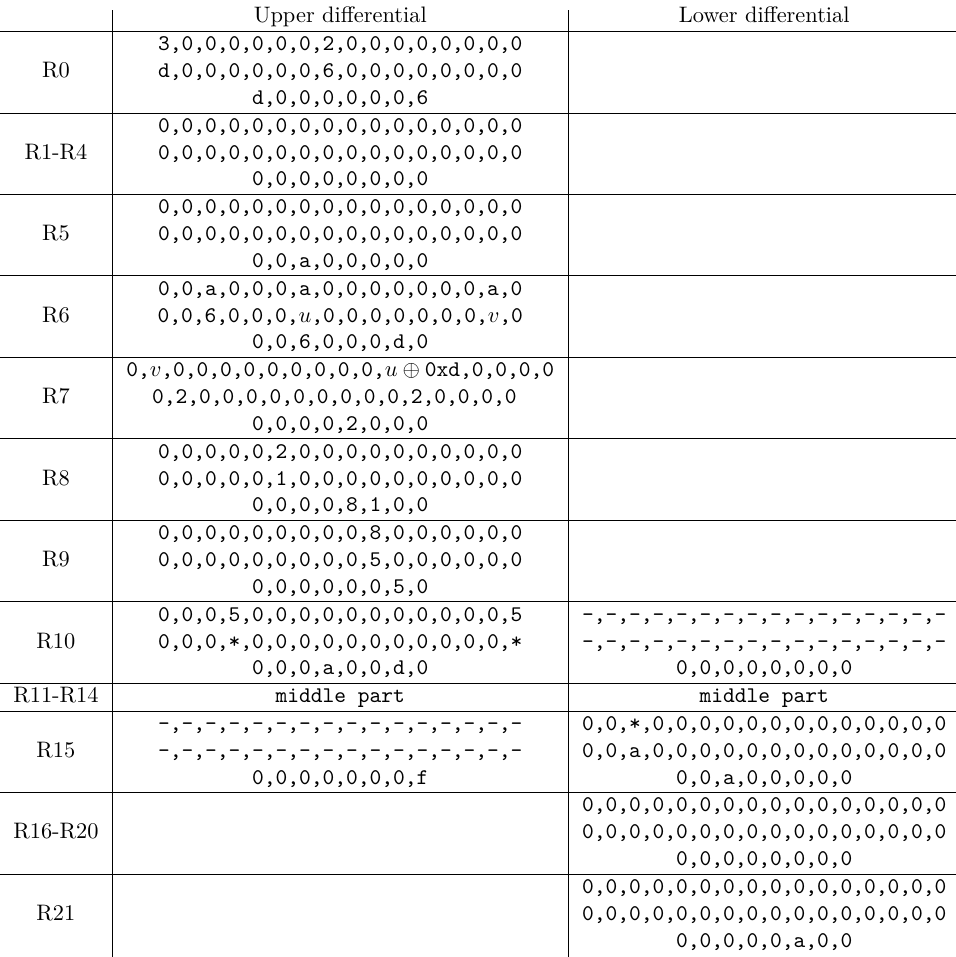
Table 17: The differentials of the 22-round distinguisher for SKINNY-64-192 , where R10 to R15 denote r = 6-round middle part, u satisfies DDT[ 0xa ][ u ] > 0 and DDT[ u m